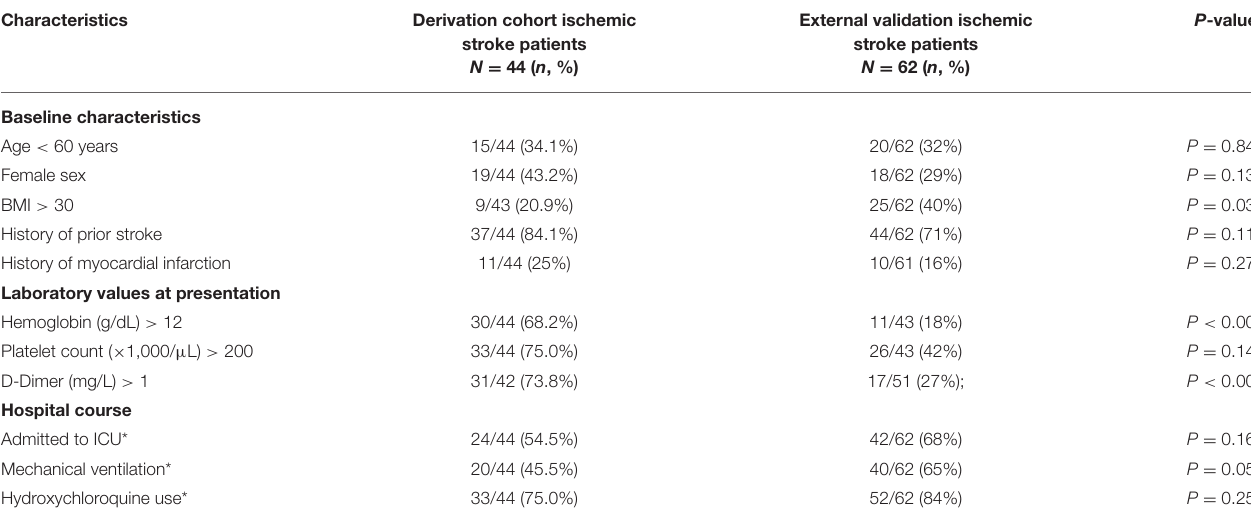
TABLE 2 | Characteristics of COVID-19 ischemic stroke patients in the derivation and external validation cohorts. Characteristics